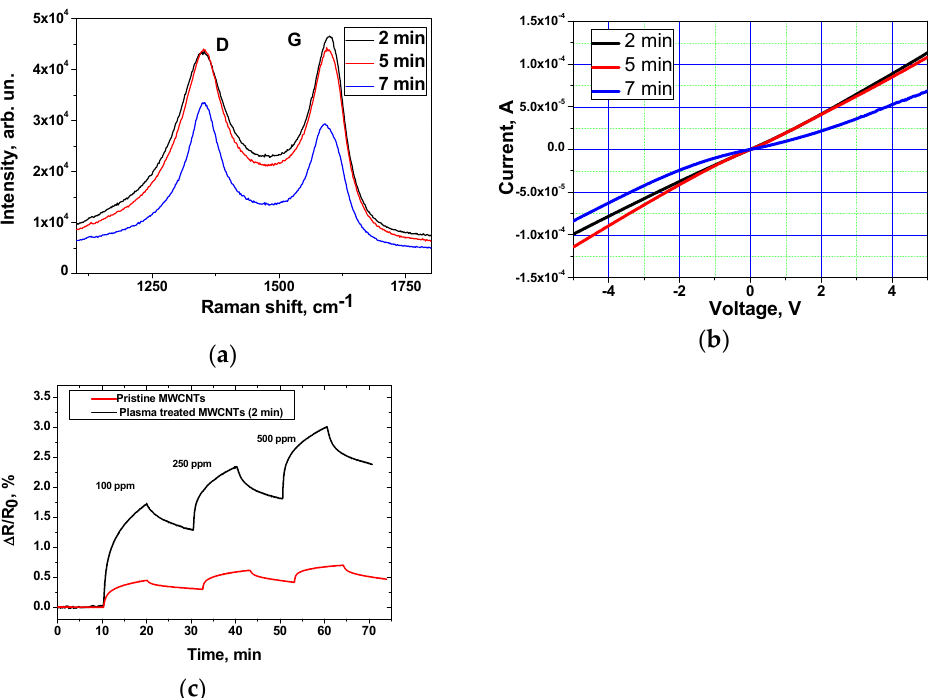
Figure 2. SEM images of MWCNTs after functionalization at various durations: ( a ) 2 min, ( b ) 5 min, and ( c ) 7 min. ( d – f ) TEM images of MWCNTs synthesized (non-treated sample).